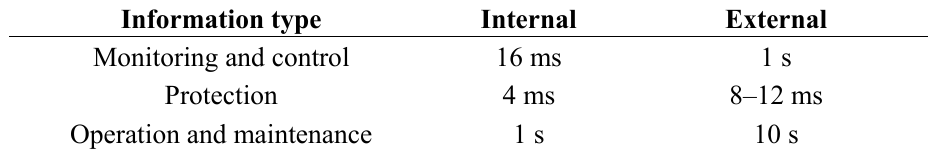
Table 3. Timing requirements for different applications (IEEE 1646 STD).